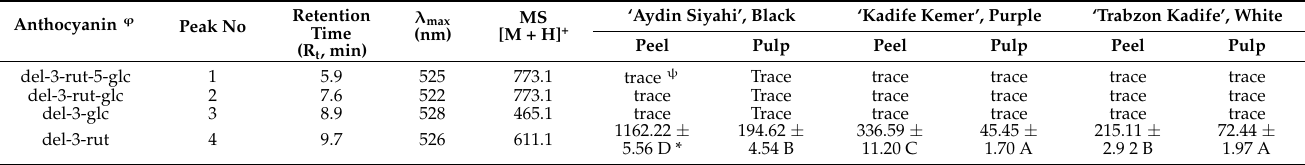
χ Values represent the mean ± SD of three independent extractions and determinations. ϕ del-3-rut-5-glc: delphinidin-3-rutinoside-5-glucoside; del-3-rut-glc: delphinidin-3-rutinoside-glucoside; del-3-glc: